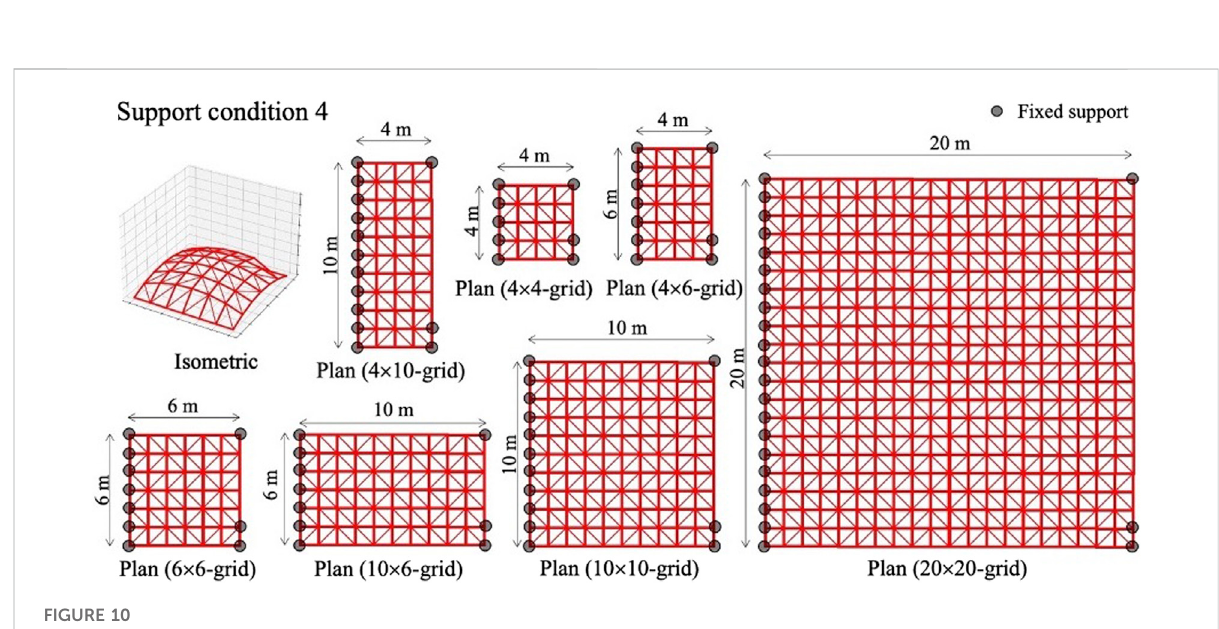
FIGURE 10 Structural models for test phase: Support condition